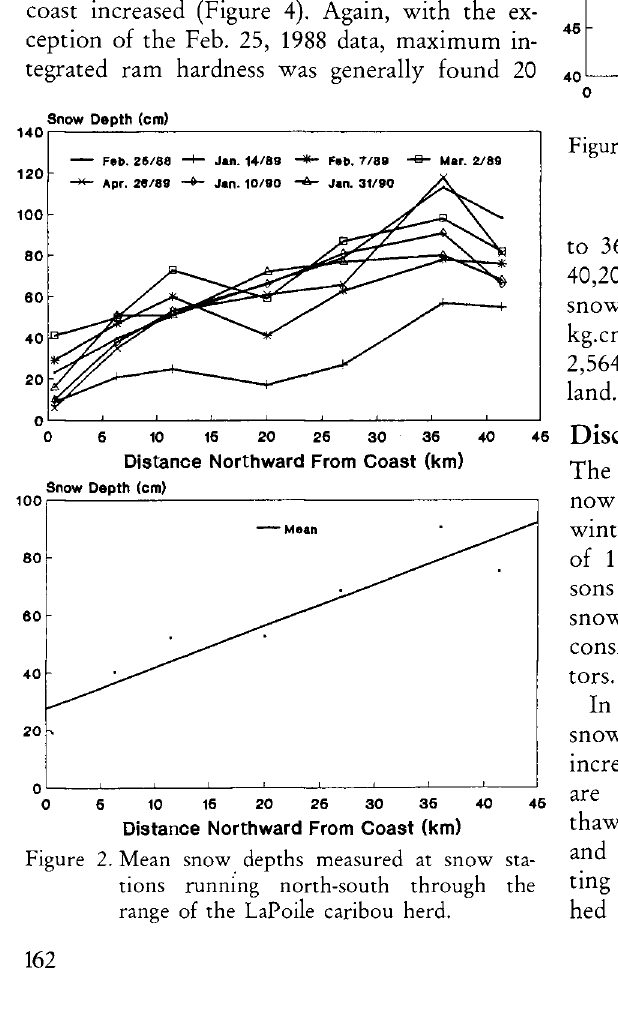
Figure 3. Mean snow ram hardnesses measured at snow stations running north-south through the range of the LaPoile caribou herd. to 36 km inland (average 3,804 kg.cm, ange 0¬ 40,200 kg.cm). Near the coast (0-20 km inland) snow integrated ram hardness averaged 1,563 kg.cm (range 0-29,055 kg.cm) while it averaged 2,564 kg.cm (range 0-13,200 kg.cm) 42 km in